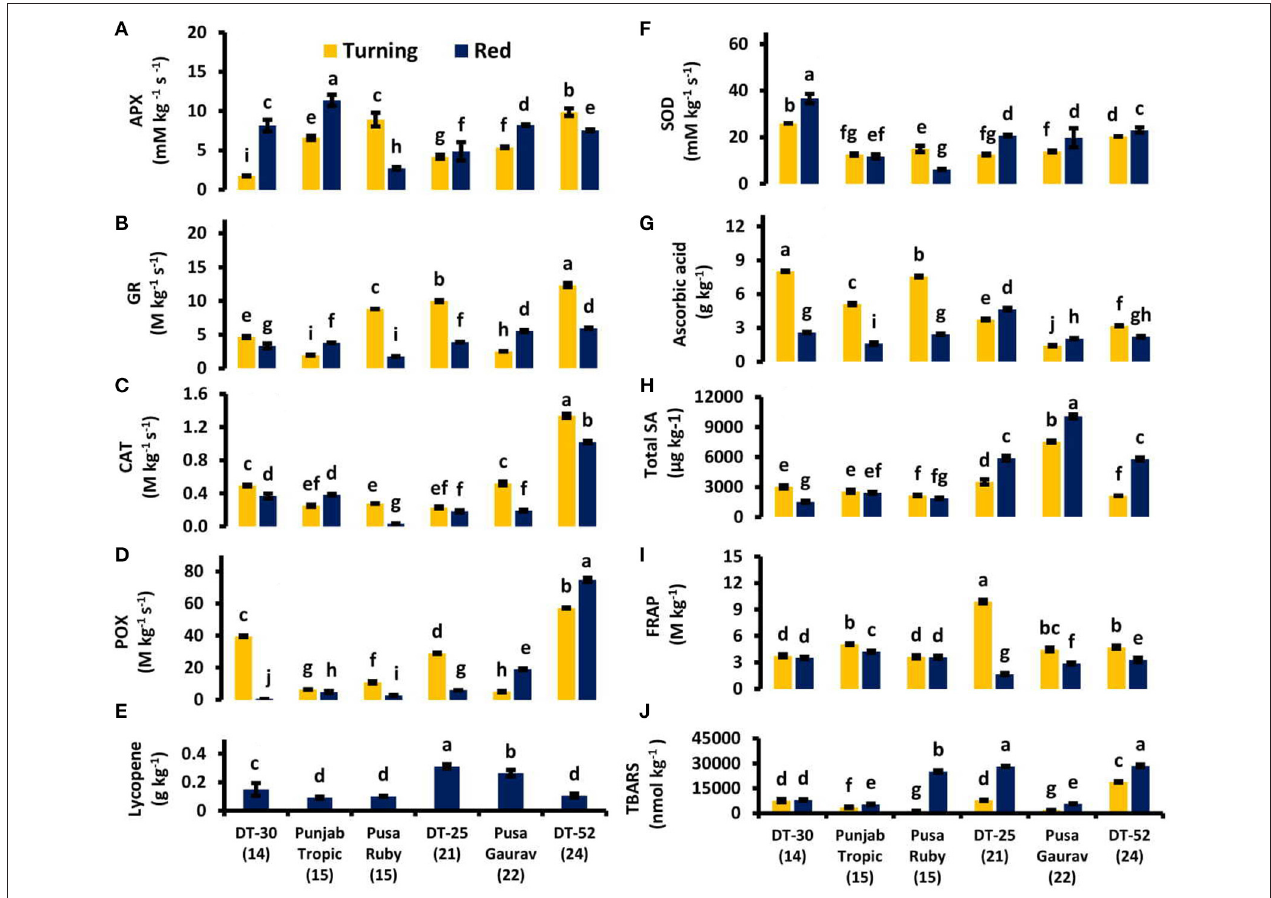
FIGURE 6 | Ascorbate peroxidase (APX) (A) , glutathione reductase (GR) (B) , catalase (CAT) (C) , peroxidase (POX) (D) , lycopene (E) , superoxide dismutase (SOD) (F) activities and ascorbic acid content (G) , total endogenous salicylic acid (SA) (H) , total antioxidants by ferric reducing ability of plasma (FRAP) (I) and lipid peroxidation by thiobarbituric acid reactive substances (TBARS) (J) in tomato fruit at turning and red stages. Bottom axis represents the name of tomato lines, and numbers enclosed in parentheses represent shelf life. Each graph represents the mean of three replications, and vertical bars represent ±